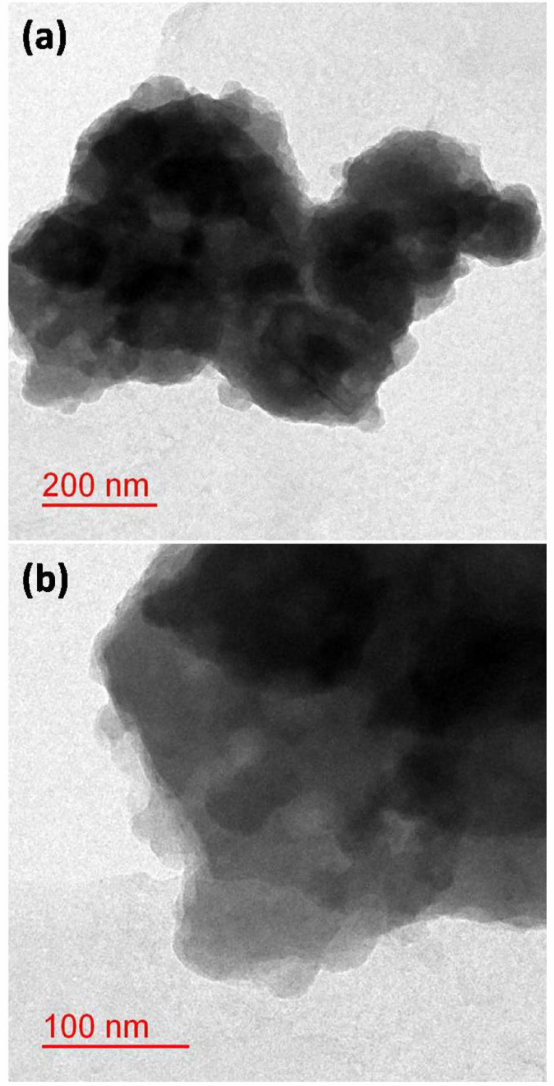
Figure 6. ( a , b ) TEM micrographs of Zn(OH) 2 /ZnO bionanocomposite taken at two different